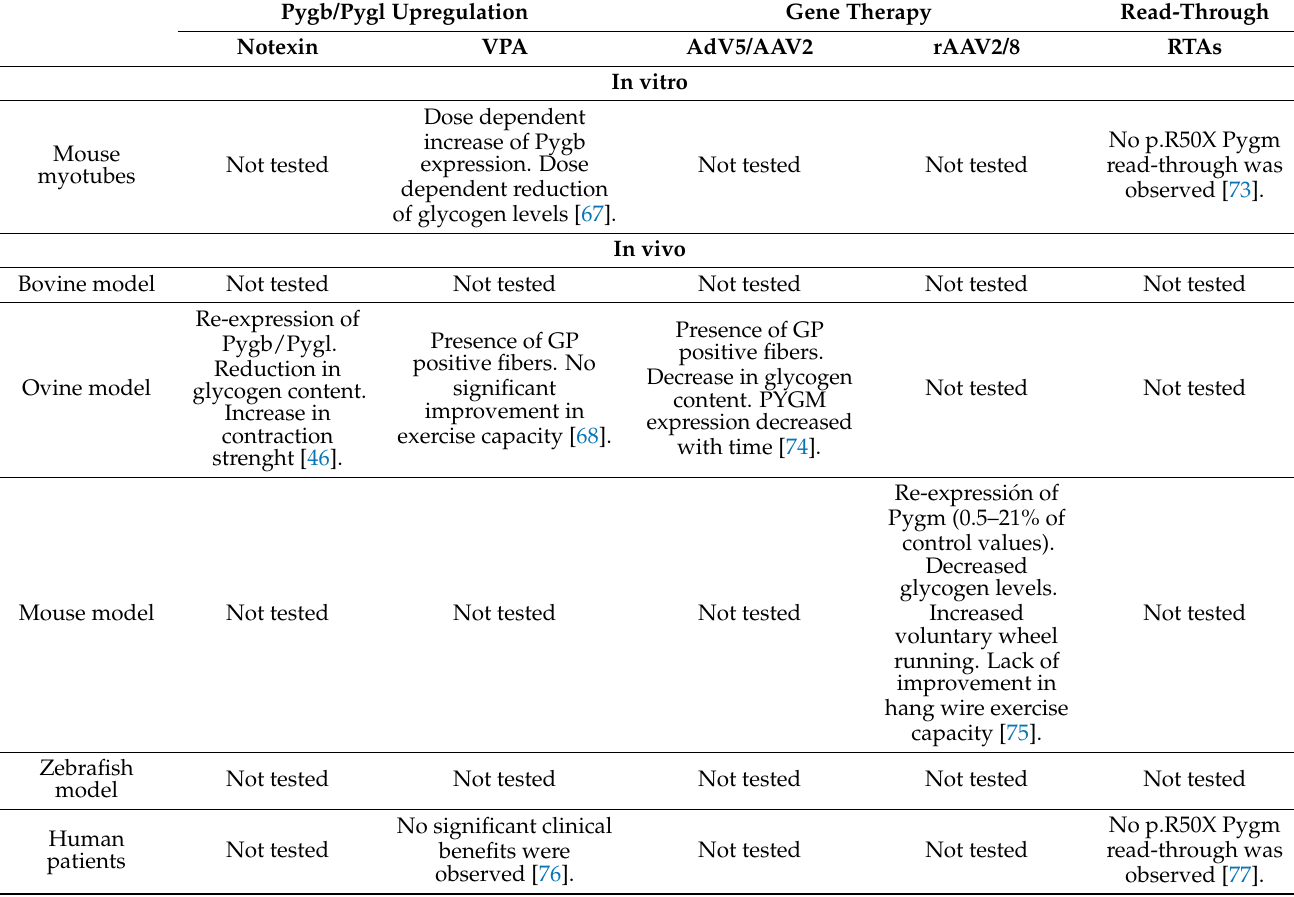
Table 3. List of therapeutic approaches tested in the different preclinical research models, and if further tested in humans, data are also